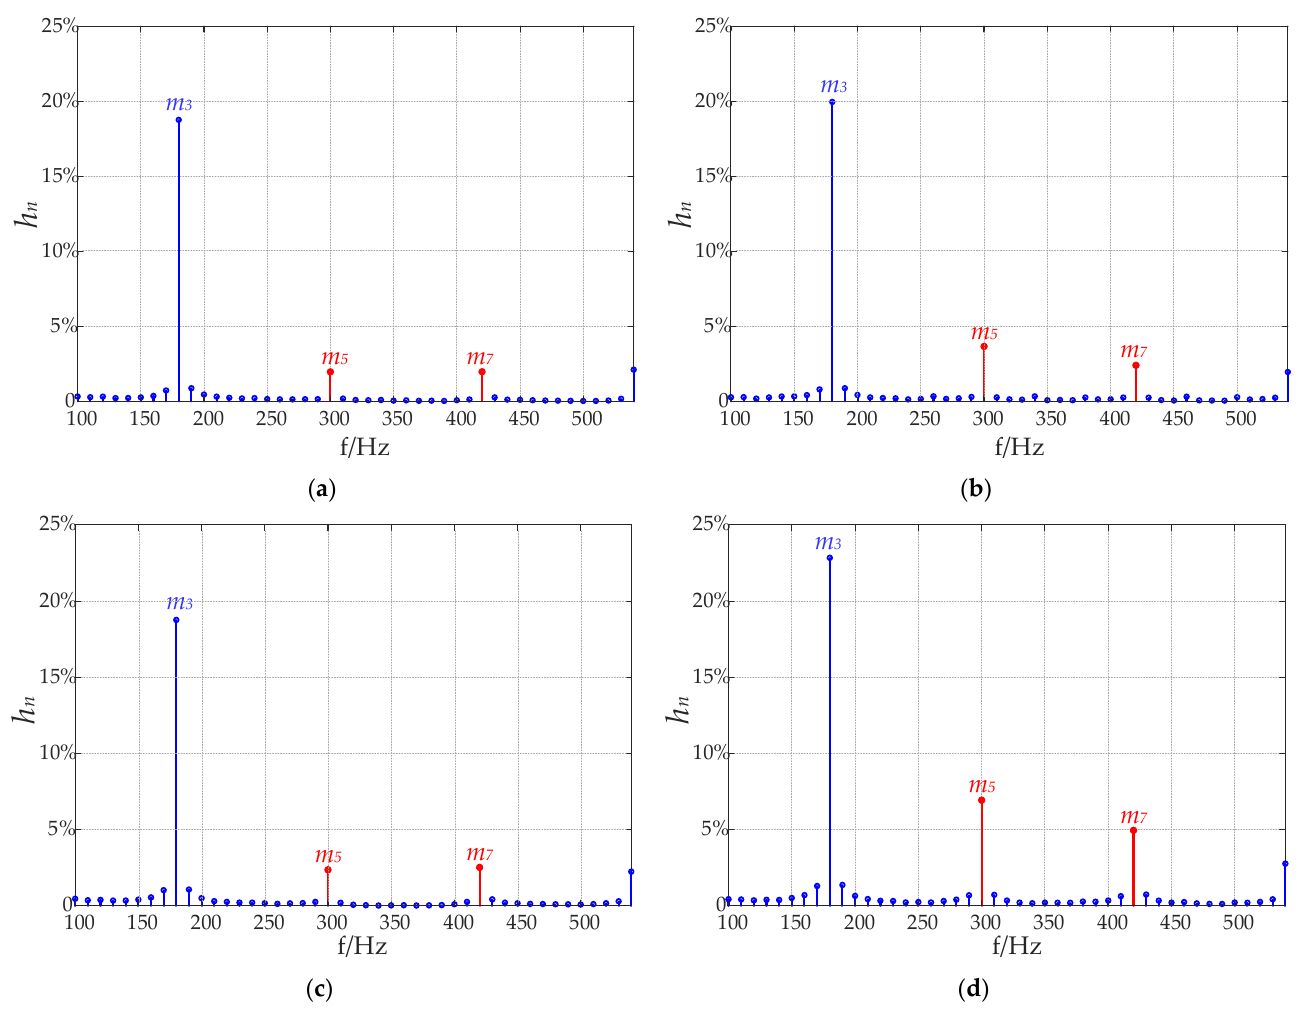
Figure 12. Experiment waveform of output phase voltage at m = 0.909: ( a ) strategy A; ( b ) strategy B; ( c ) strategy C; ( d ) strategy D.